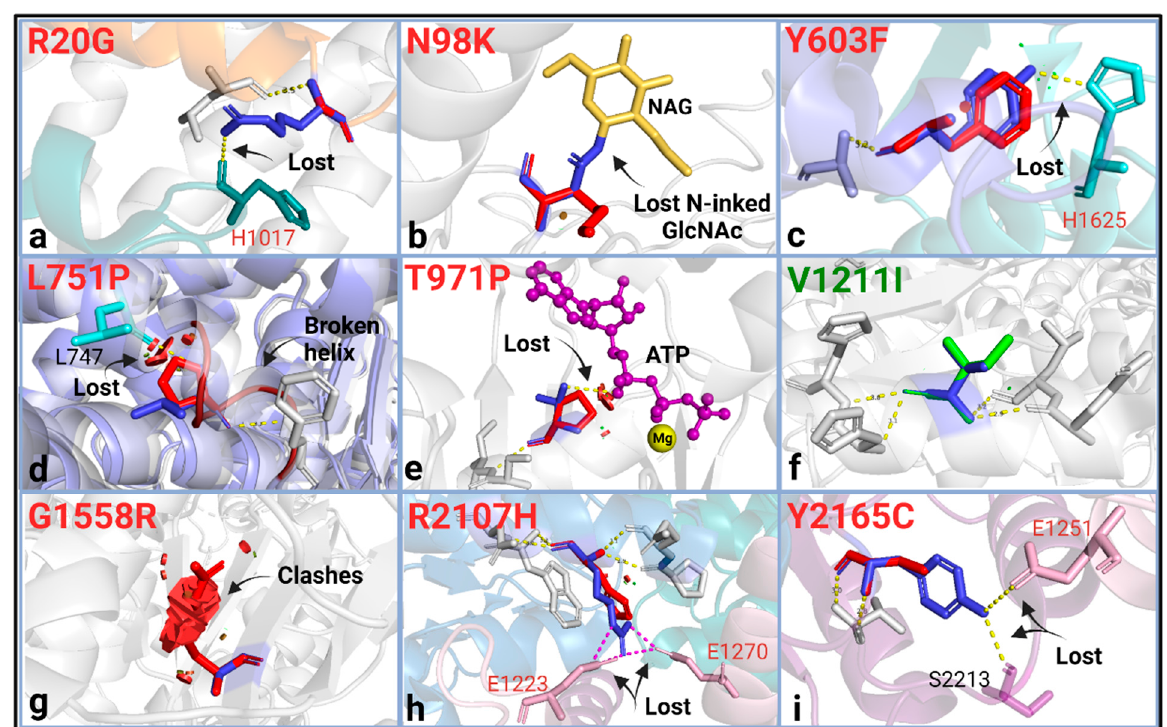
Figure 3. Protein structural analysis of the ABCA4 VUS. WT residue (blue) and the substitution (green when there is no change, orange for mild change, and red for substantial change) were shown as sticks with their structural effects using the “mutagenesis” feature in PyMol2. ( a ) R20G; broken interchain H-bond (IH1 (orange)-NBD1 (green) interaction). ( b ) N98K; WT glycosylated Asn is replaced with Lys, which would otherwise be a neutral substitution. ( c ) Y603F; loss of an interchain H-bond (ECD1 (blue)-ECD2 (light green) interaction). ( d ) L751P; disrupted H-bond necessary for helix formation and steric clashes due to Pro not being able to accommodate into the TMD helix. ( e ) T971P; loss of polar contact with the ATP molecule (purple), steric clashes with ATP. ( f ) V1211I; no structural change was found. ( g ) G1558R; severe steric clashing. ( h ) R2107H; interdomain salt bridge breakage (NBD2 (blue)-NBD1-R1 (pink) interaction). ( i ) Y2165C; intra- and interchain H-bond breakage (NBD2-R2 (purple)-NBD1-R1 (pink) interaction). These analyses predicted the effects of side chains on the protein stereochemistry and bonding/interaction aspect of the variation and were mostly performed using the cryo-EM structures of the human ABCA4 [41–43,51–57]. Steric clashes were shown here for the highest probability rotamer but were only given when all possible rotamers resulted in clashing interactions. The bonds were given for the highest possible